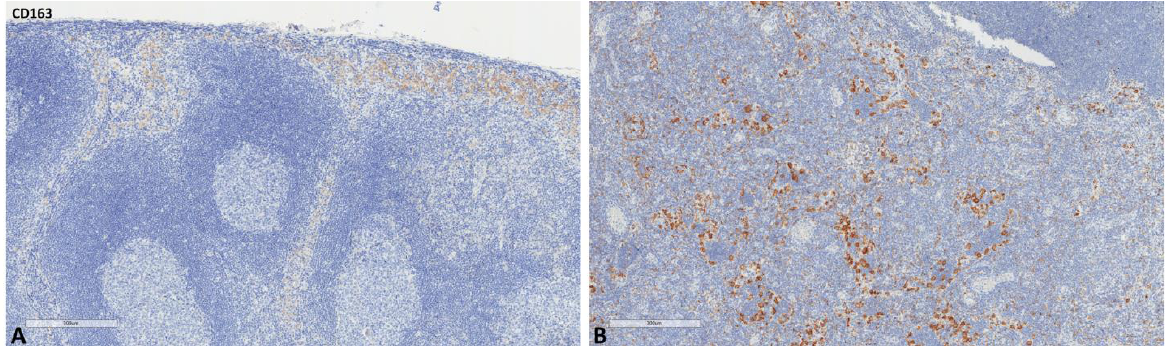
Figure 3. Representative microscopic images of CD163 expression in a normal cancer-draining lymph node ( A ) and a normal non-cancer-draining lymph node ( B ).